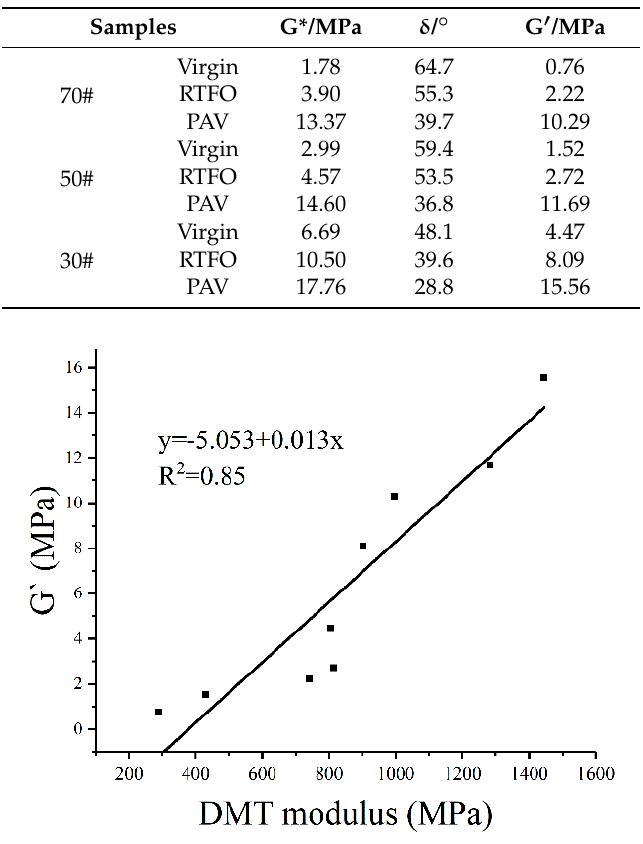
Figure 8. Force curve of bitumen in the Atomic Force Microscope (AFM) test.